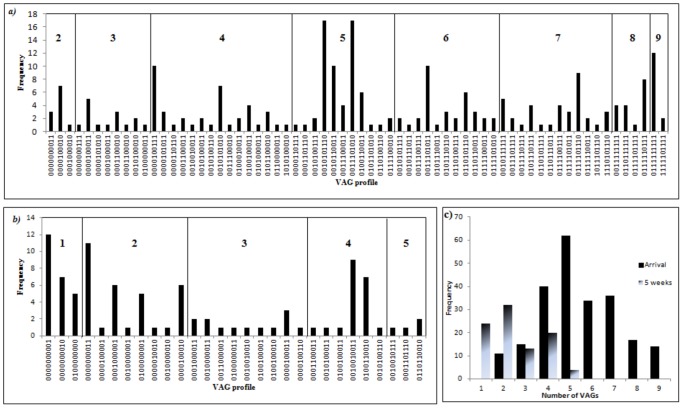
VAG profile diversity for all flocks.
a) Shows the VAG profiles identified at t = 0 (arrival of chicks). Profiles consisting of 4 VAGs were the most diverse, with differences in iron acquisition genes being the most abundant, while profiles 0010101110 (irp2
+, papC+, vat+,cvi
+, sitA
+) and 0011101010 (irp2
+, iucD
+, papC
+, vat+, sitA
+) both with 5 VAGs were the most common profile identified b) Shows the VAG profiles identified at t  =  week 5. VAG profile diversity had declined over time. Most diversity was detected with the possession of 3 VAGs. No isolates carried more than 5 VAGs c) Comparison of total number of VAGs carried by individually tested E. coli at t = 0 and 5. Profile 206 (0000000000) excluded from both graphs. Not all profiles were represented in all four cycles.